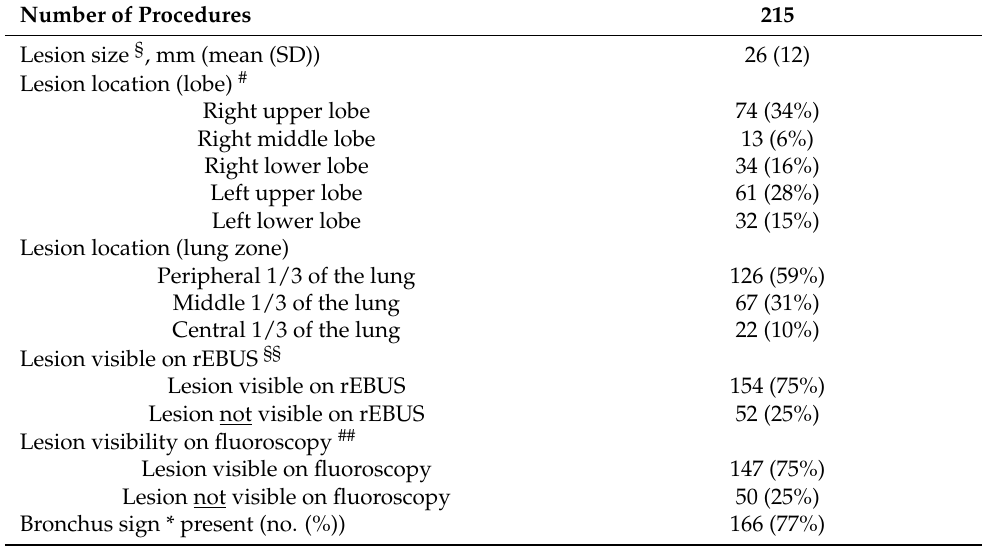
Table 1. Procedure and lesion characteristics.